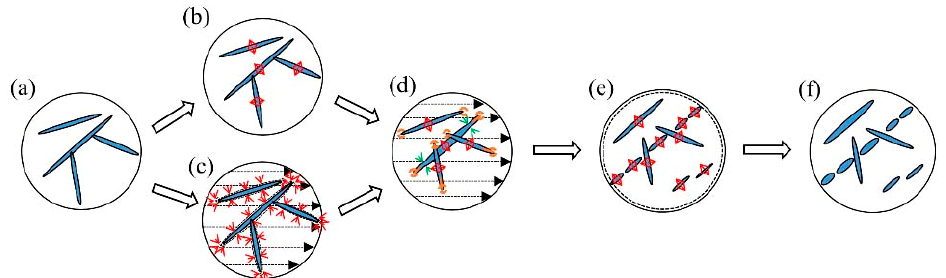
Figure 13. Transformation mechanism of α′ martensite induced by the ECP treatment: ( a ) Prior β grains contour (black circle) and α′ martensite (blue area), ( b ) thermal effect, the red double arrows indicate the direction of expansion, ( c ) electric effect, the red double arrows indicate skin effect and the black dashed arrows are the directional current, ( d ) electrothermal coupling effect, the yellow area indicates the concentration of energy, and the green arrow indicates the location of the break, ( e ) fragmentation of α′ martensite, the black dashed circle is the initial prior β grains contour, and the black solid circle is the prior β grains contour after fragmentation, and ( f ) fragmented α′ martensite and enlarged prior β grains contour after ECP treatment.